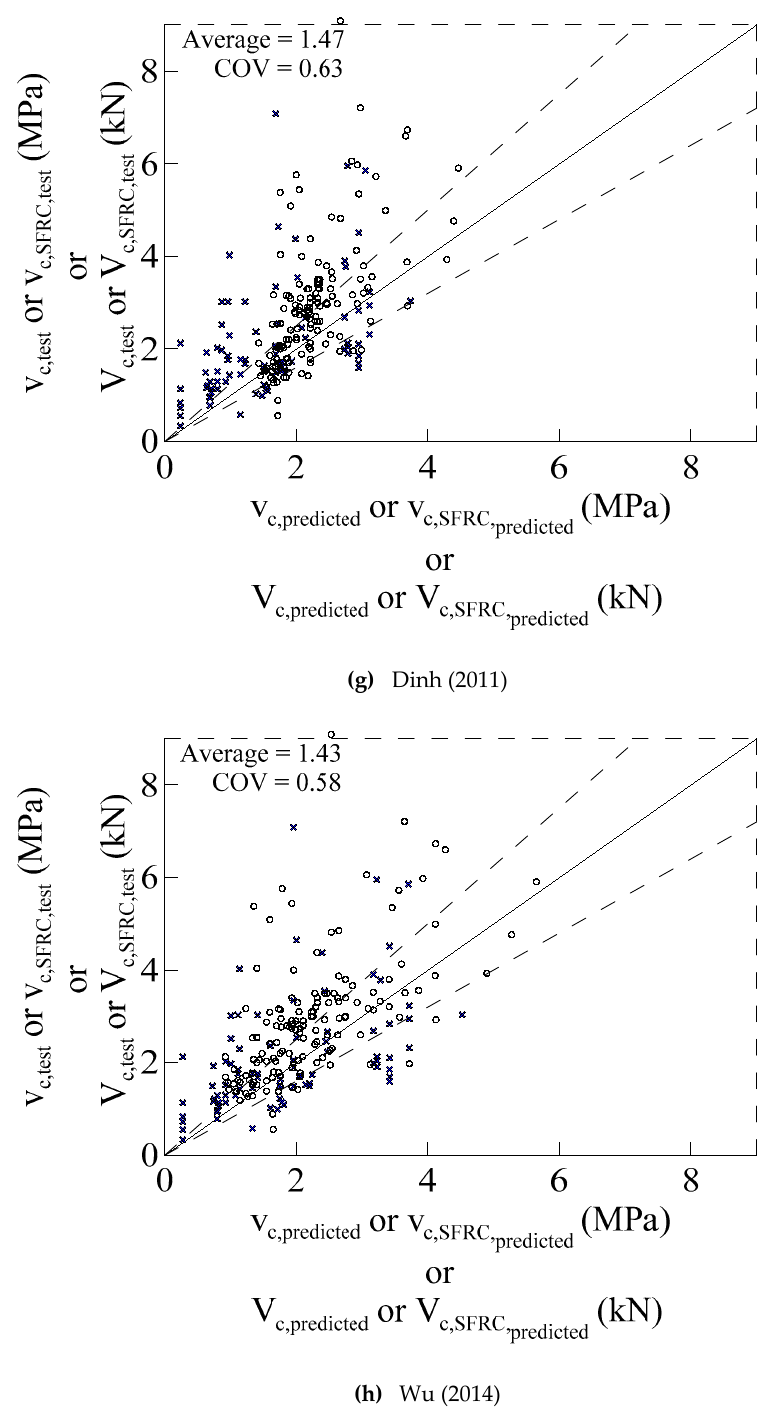
Figure 3. Comparison between measured and predicted shear strengths. Table 1. Statistical evaluation results for comparison between measured and predicted shear strengths.